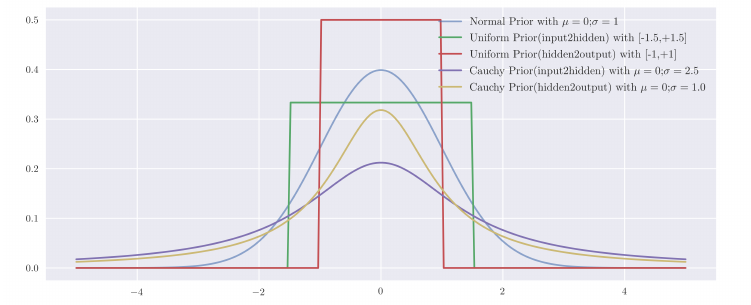
Figure 2. The Probabilistic Density Curves of Normal, Uniform, and Cauchy Priors. This graph demonstrates the probabilistic density curve for each of the prior applied in this research, i.e., Normal, Uniform and Cauchy priors. Here, the further specification of input-to-hidden, hidden-to-hidden priors are defined as the hierarchical shrinkage in variance of the corresponding priors.